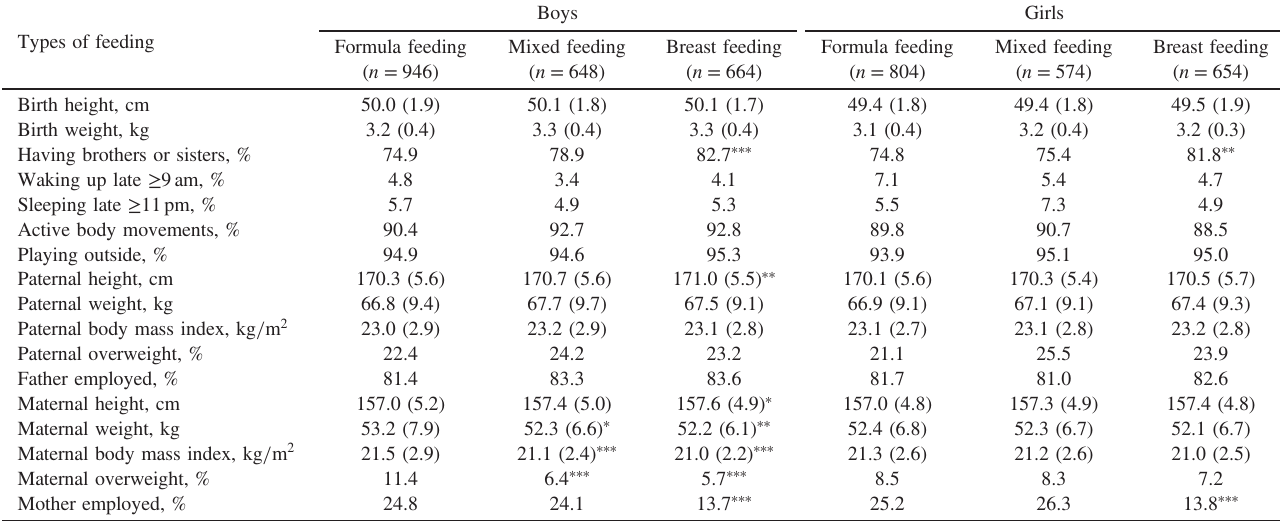
Table 1. Sex-speci fi c mean values (standard deviations) and proportions of baseline characteristics at age of 3 years among 2,258 boys and 2,032 girls, IBACHIL Types of feeding